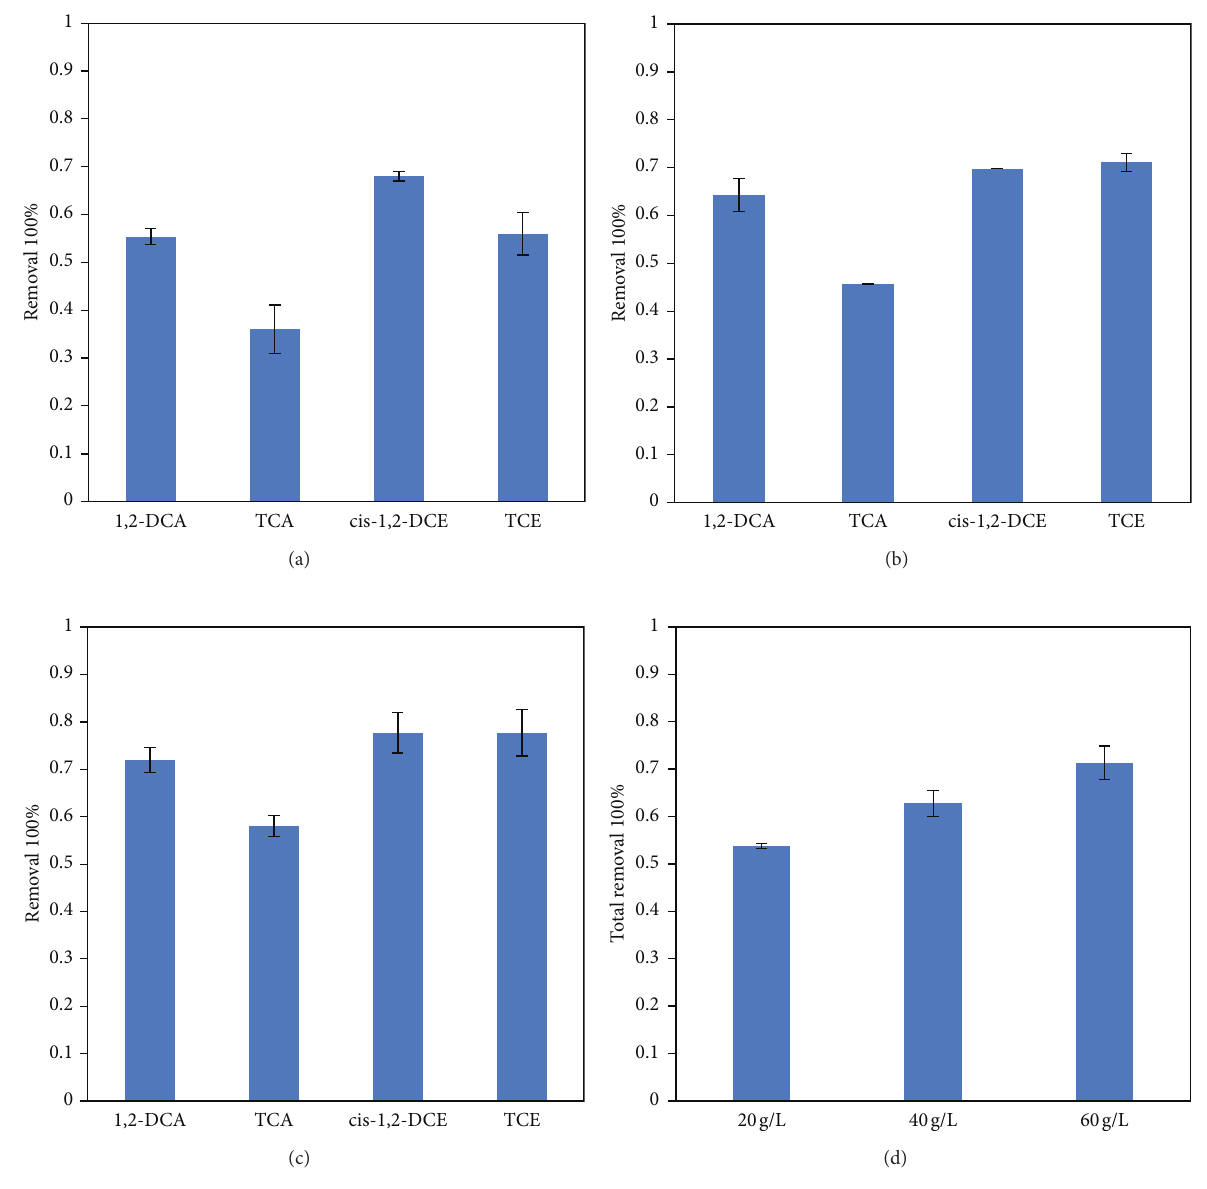
Figure 1: The depletion of chlorinated organic solvents by activated persulfate at 30 ∘ C with different persulfate dosages: (a) 20 g/L, (b) 40 g/L, and (c) 60g/L, and (d) the total removal of chlorinated organic